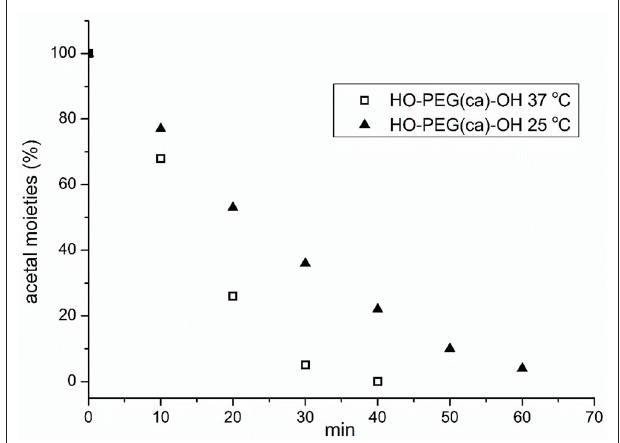
FIGURE 6 | Decreasing acetal of the cinnamaldehyde acetal containing HO-PEG(ca)-OH at 25 and 37 ◦ C, respectively, in deuterated phosphate buffer at pH 5.0.